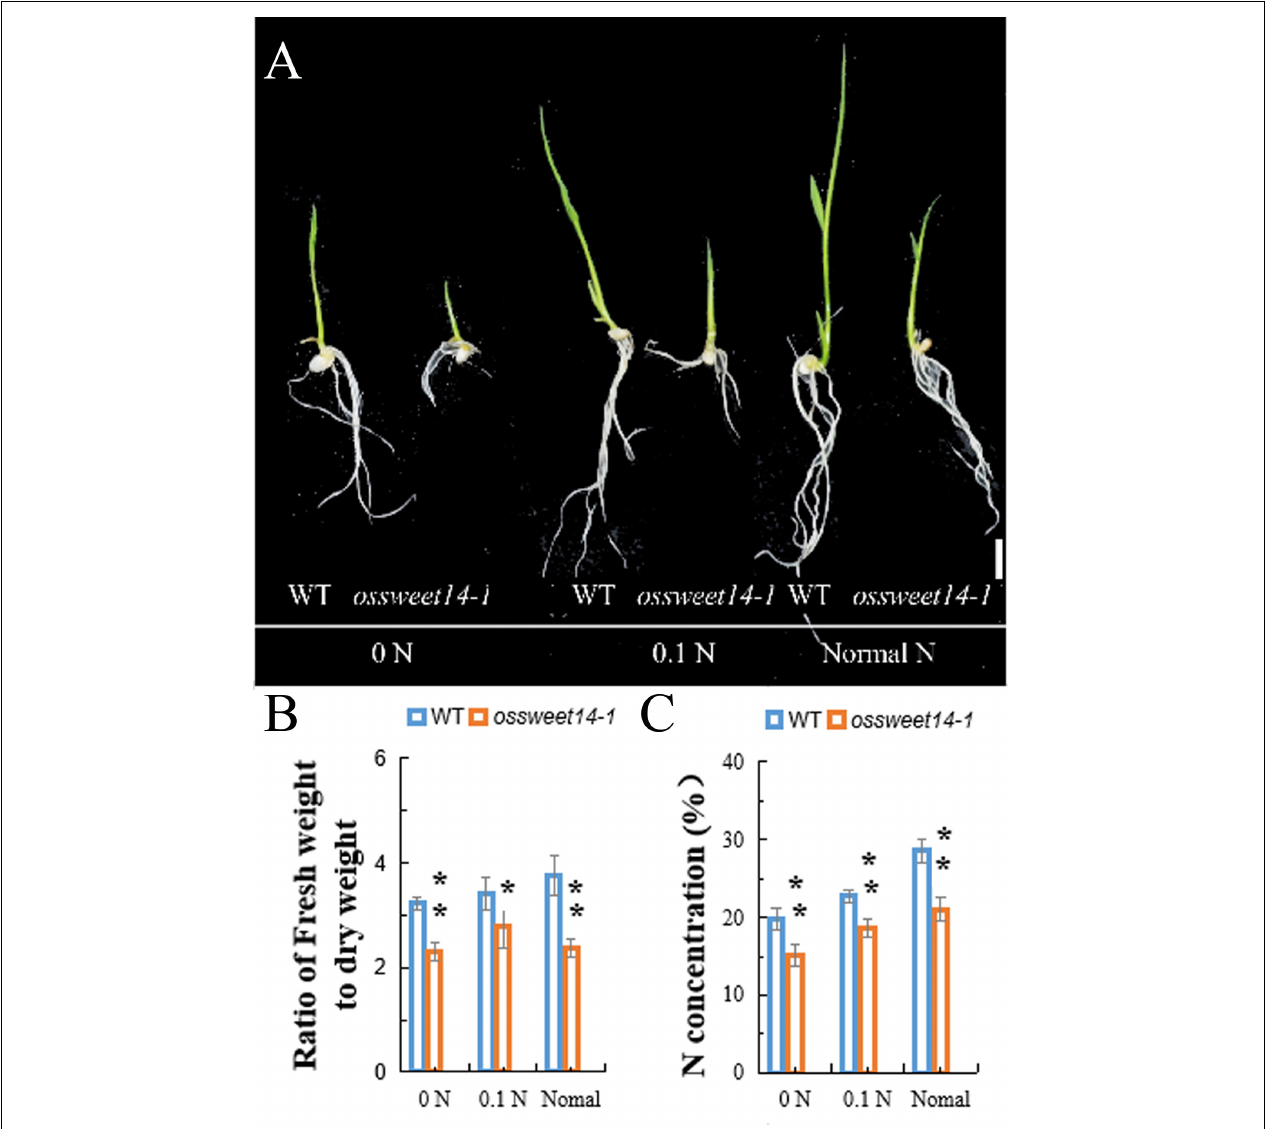
FIGURE 3 | Characterization of the OsSWEET14–1 mutant at the seedling stage under multiple N contents of Yoshida medium without sucrose. (A–C) Phenotypes of OsSWEET14–1 and WT under multiple N concentrations in Yoshida medium. (A) Picture of seedling plants at 7 days after germination; (B) ratio of fresh weight to dry weight; (C) N concentration. 0 N: Yoshida medium without nitrogen, 0.1 N: Yoshida medium with 10% nitrogen, and normal medium: Yoshida medium with a normal content of nitrogen. Scale bar = 1 cm. Each data point represents the mean ( ± SE) from at least four different plants. * P < 0.05; ** P <